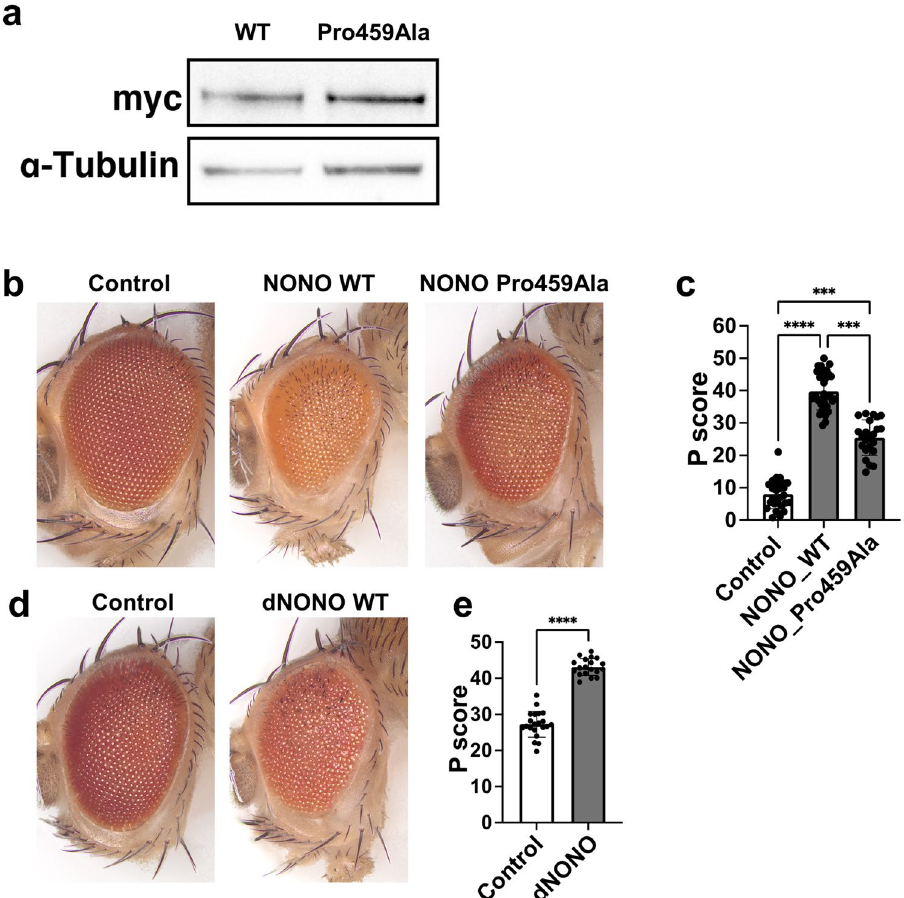
Figure 2. Functional evaluation of NONO variant in Drosophila. ( a ) Western blotting confirmed the expression of the NONO WT and the Pro459Ala variant. Myc-NONO WT or Myc-NONO Pro459Ala was expressed throughout Drosophila bodies and detected with anti-Myc antibody. Anti-α-tubulin was used as a loading control where indicated. ( b ) Representative bright-field microscope images of fly eyes displaying eye-specific ectopic expression of Myc-NONO WT and Myc-NONO Pro459Ala using the GMR-Gal4 driver, reared at 20 °C. ( c ) Quantification results of the phenotypic scores in control ( n = 29), Myc-NONO WT ( n = 32), and Myc-NONO Pro459Ala ( n = 23). Data represent the mean ± SD. Statistical comparisons were conducted using nonparametric ANOVA (Kruskal–Wallis test) followed by Dunn’s multiple comparisons test. n.s.: not significant. *** P < 0.001, **** P < 0.0001. ( d ) The fly eyes displaying eye-specific overexpression of nonA using the GMR-Gal4 driver, reared at 29 °C. ( e ) Quantification results of the phenotypic scores in control ( n = 21) and nonA ( n =